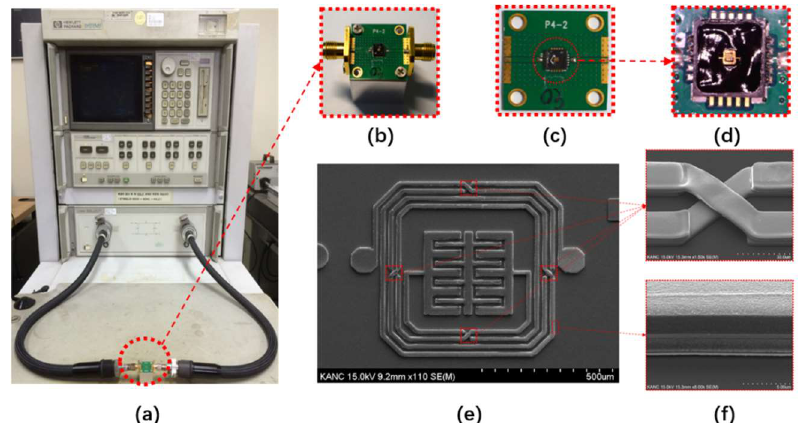
Figure 6. S-parameter measurement setup of the proposed IPD-based BPF with enlarged views of different parts. ( a ) Measurement setup. ( b ) BPF installed on an aluminum cube. ( c ) Top view of the entire PCB. ( d ) Top view of the packaged chip on the PCB. ( e ) Top view of SEM image. ( f ) Enlarged air-bridge area and cross-section of the three metal layers.